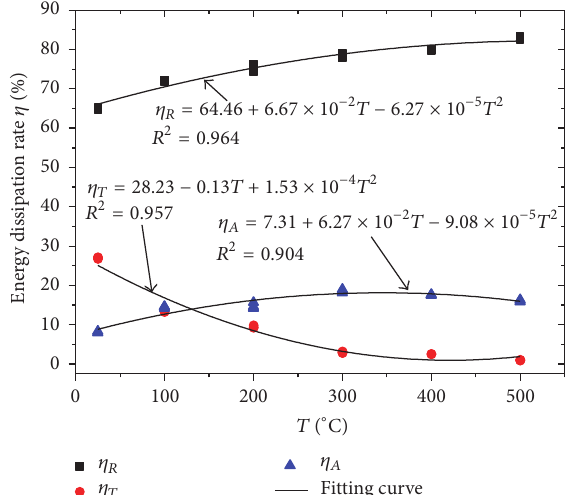
Figure7:Thevariationofenergydissipationratewithtemperatures.